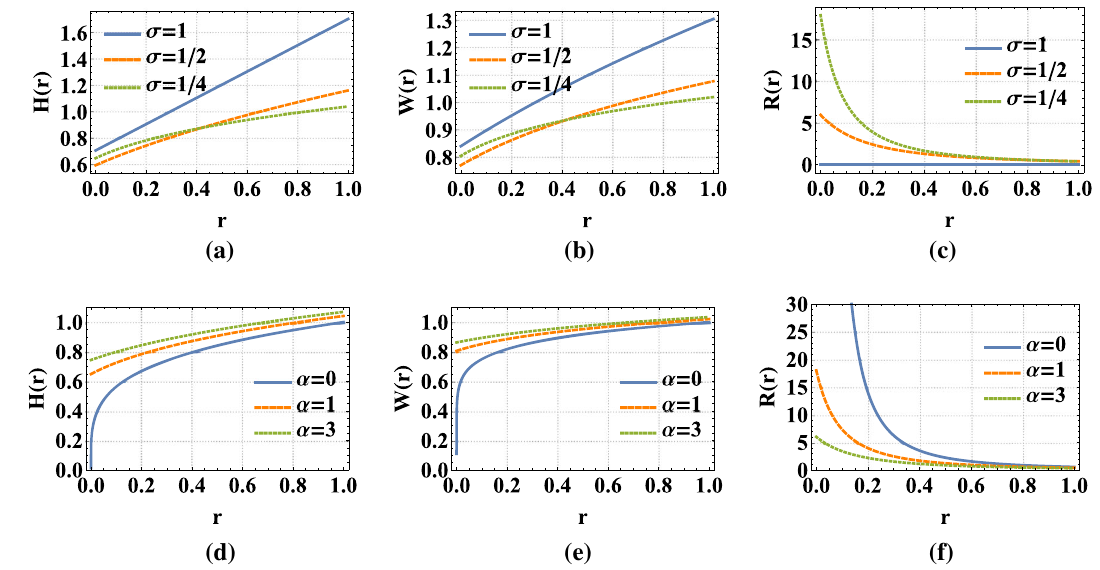
solution of W ( r ) , and f the curvature scalar R ( r ) with σ = 1 / 4. The sketch describes the spacetime geometry in the D → 4 limit